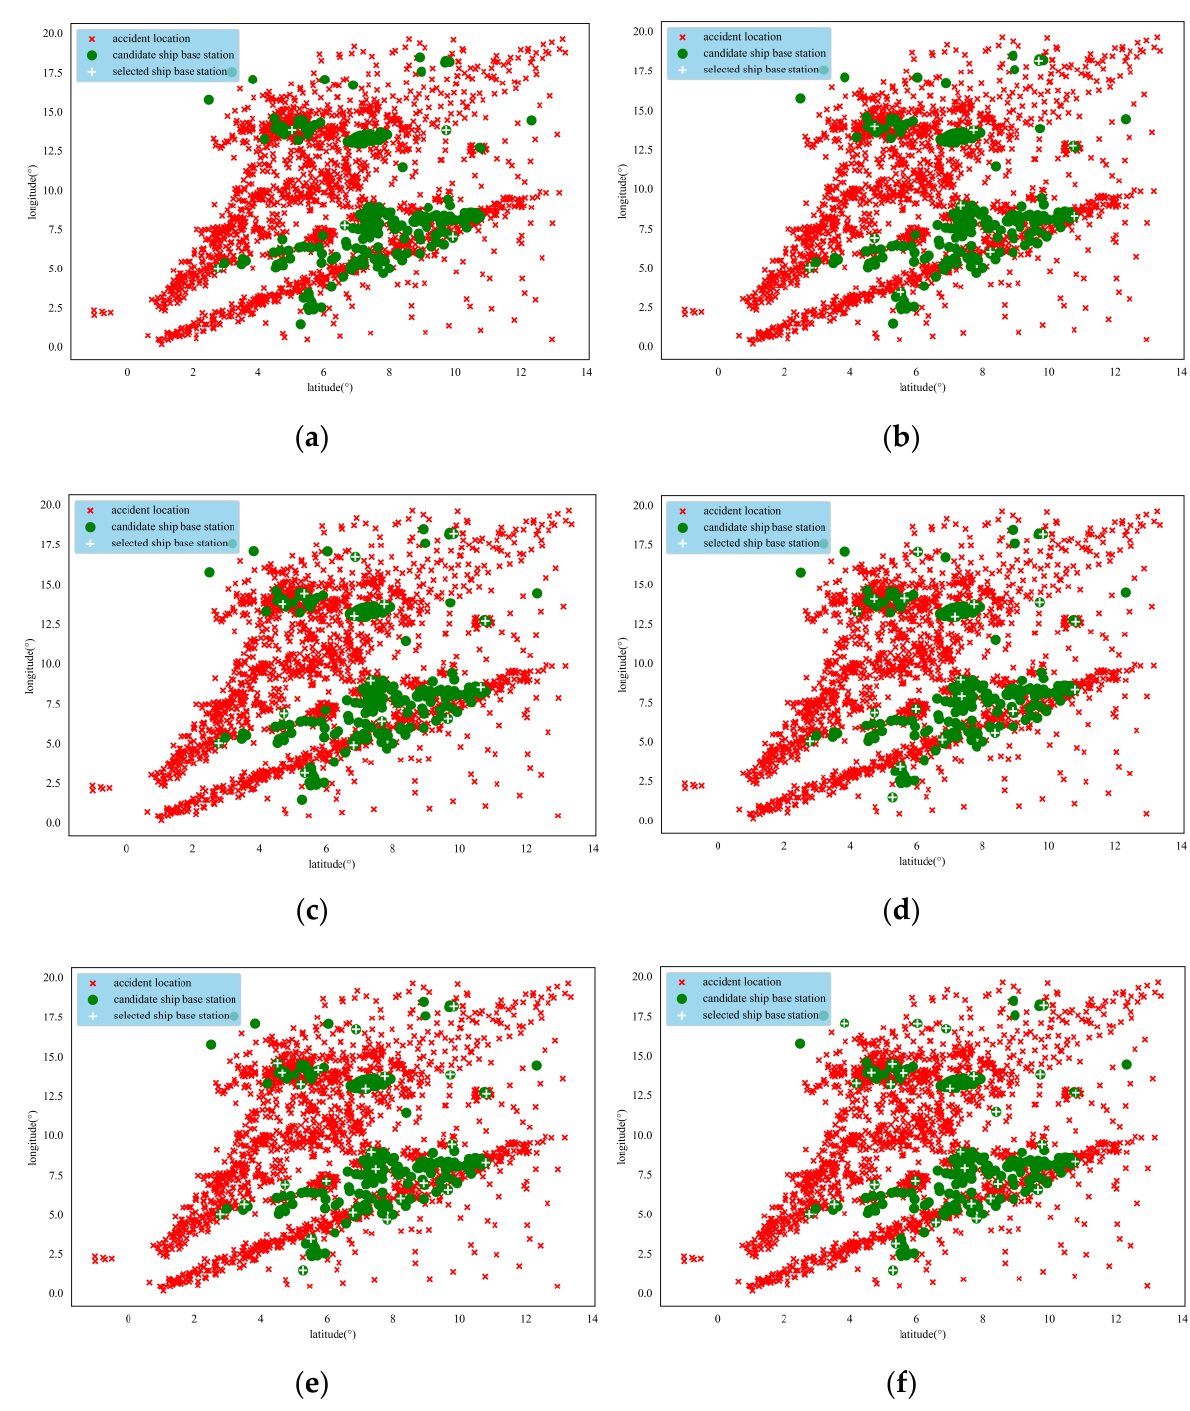
Figure 3. Optimal distributions for different numbers of base stations with EPSO model. ( a ) Distributions for 5 ship rescue base stations. ( b ) Distributions for 10 ship rescue base stations. ( c ) Distributions for 15 ship rescue base stations. ( d ) Distributions for 20 ship rescue base stations. ( e ) Distributions for 25 ship rescue base stations. ( f ) Distributions for 30 ship rescue base stations.